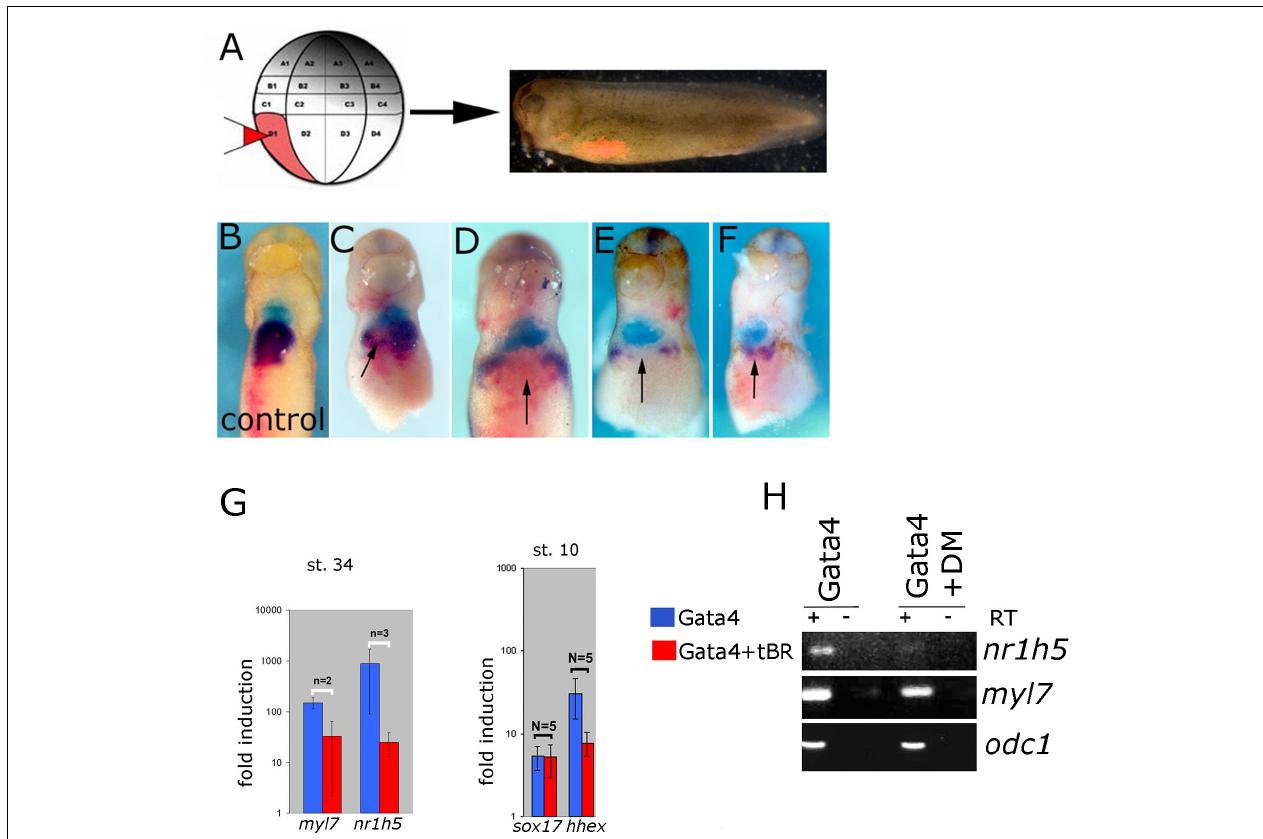
FIGURE 6 | BMP signaling is required for liver development. (A) Design of the experiment. Lineage tracer was injected (B) alone or (C–F) with ∼ 30 pg/blastomere of truncated BMP Receptor (tBR) mRNA in dorso-vegetal blastomere D1 at the 32-cell stage. Heart and liver were revealed by double WMISH of myl7 (turquoise) and nr1h5 (purple). (C–F) four examples showing attenuation of liver fate specification in vivo following localized BMP inhibition by tBR (red-pink; pointed by arrows). N = 11, all showing effect on nr1h5 expression. Ventral views are shown, anterior is up. BMP signaling inhibition attenuates liver cell fate specification in Gata4 injected AC. (G) qPCR analyses of st. 34 explants show downregulation of nr1h5 as a consequence of BMP inhibition via tBR. At st. 10, tBR has no effect on the ability of Gata4 to induce sox17 but reduces hhex induction. (H) Treatment of Gata4-expressing AC explants with 30 µ M dorsomorphin (DM) leads to downregulation of nr1h5